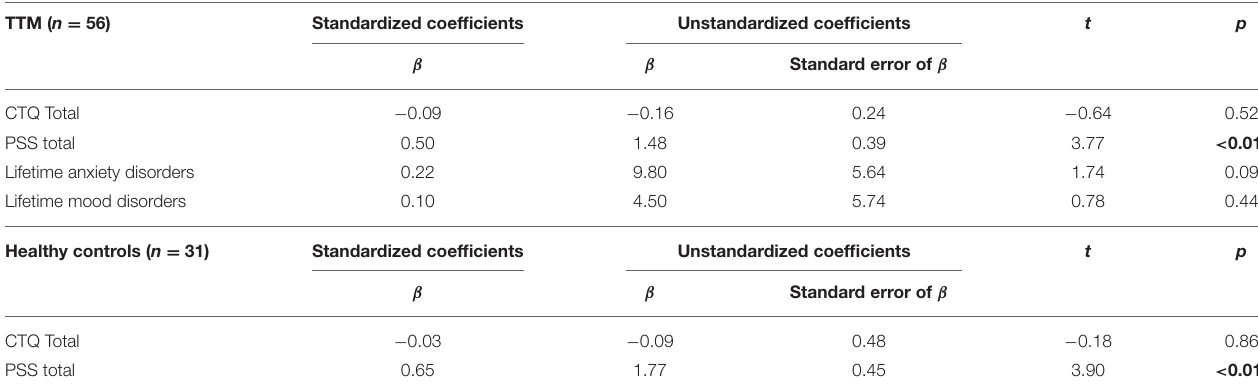
TABLE 2 | Multivariable linear regression analysis for emotion dysregulation as dependent variable, in the two groups separately. TTM ( n =